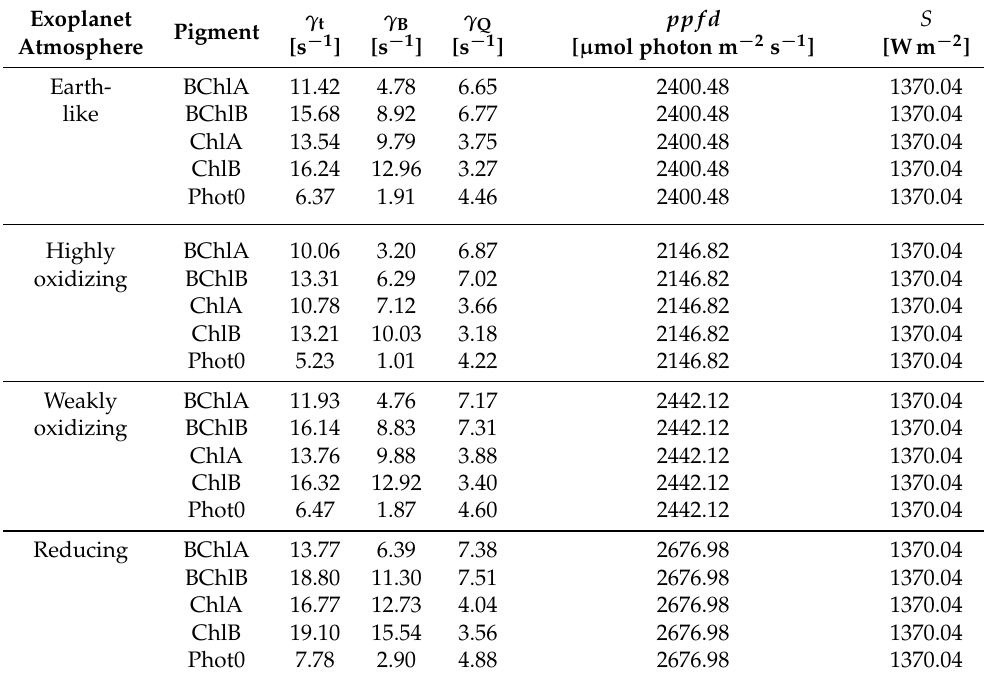
Table A2. Photosynthetic fitness metrics for Earth-like exoplanets with different atmospheres at the middle of the habitable zone (HZm) around an A5V star.